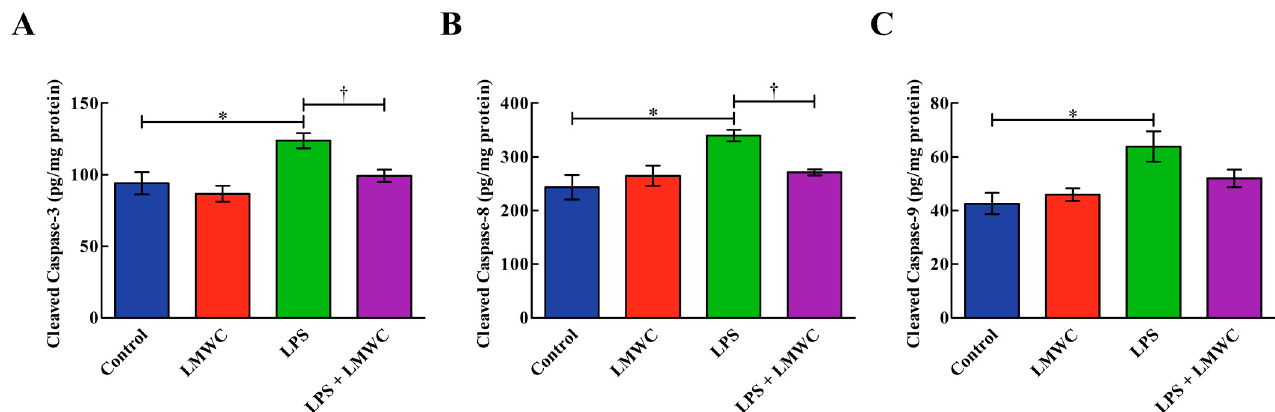
Figure 6. Effects of LMWC on the cleaved caspase contents in LPS-treated IPEC-J2 cells. ( A ) Cleaved caspase-3: cleaved cysteinyl aspartate-specific protease-3. ( B ) Cleaved caspase-8: cleaved cysteinyl aspartate-specific protease-8. ( C ) Cleaved caspase-9: cleaved cysteinyl aspartate-specific protease-9. Cells were pretreated with LMWC (400 µ g/mL) for 2 h, followed by cotreatment with LPS (5 µ g/mL) for another 6 h. Data are presented as the mean ± standard error ( n = 4). * Means significant difference compared with the control group ( p < 0.05). † Means significant difference compared with the LPS group ( p < 0.05).